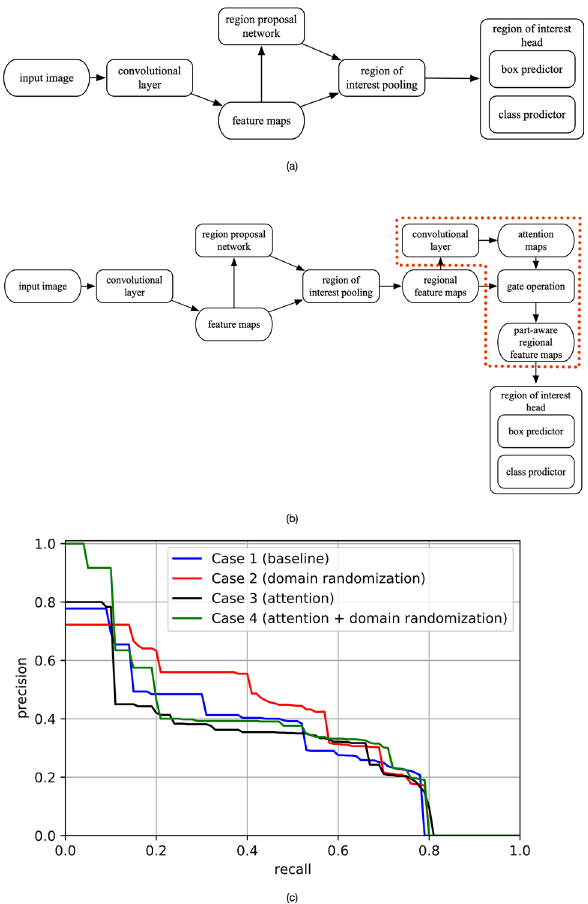
Figure 3. Object detection model used in this study for bird detection and the performance results of the related experiments: ( a ) Faster R-CNN, which is the state-of-the-art model in most object detection tasks. In this study, we selected ResNet-50 as the backbone for feature extraction (represented by the “convolutional layer” stage of the figure). We also attached Feature Pyramid Network to Faster R-CNN to render effective fusion of multiscale information; ( b ) Object detection models trained with the attention mechanism (represented by the dotted region), which was used for the performance comparison with our proposed domain randomization- enhanced deep learning model; and ( c ) precision-recall curve (at IoU = 0.5) for Case 1 (baseline), Case 2 (domain randomization), Case 3 (attention) and Case 4 (attention + domain